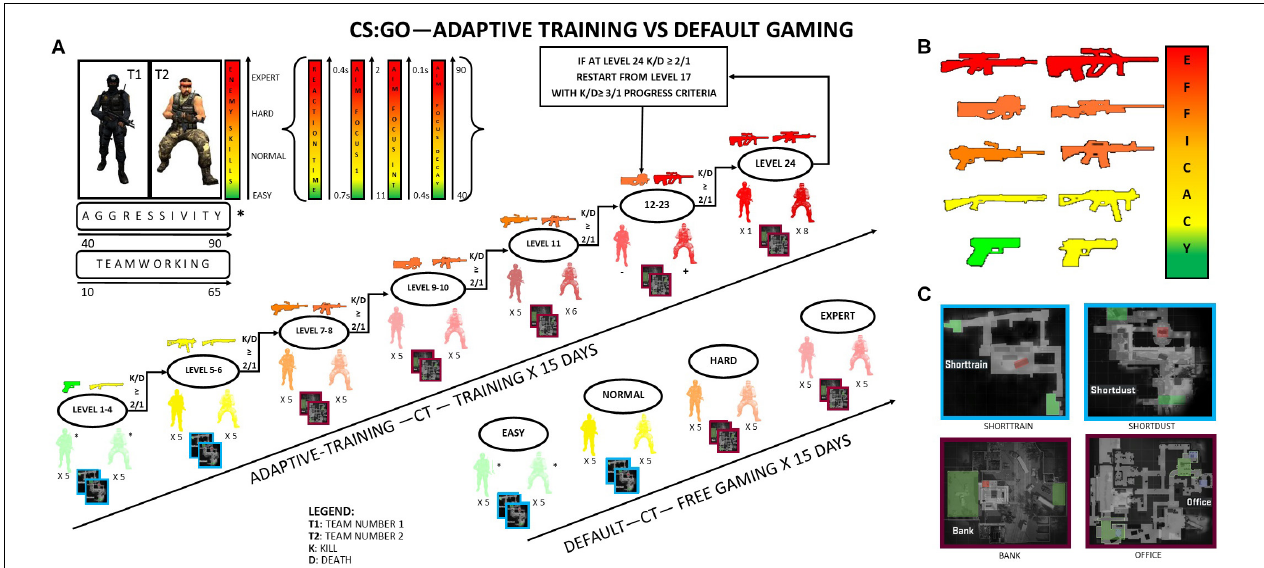
FIGURE 1 | Scheme of the experiment protocol. (A) At the beginning of the game, the player could join one of the two teams available in the game: Team 1 or Team 2. The A-CS:GO group played a customized game in which the progression in the game was established on the bases of the Death/Kill (K/D) ratio. If a player reached the K/D ≥ 2/1 for two consecutive rounds, he/she could proceed into the next level. Once reaching level 24, participants restarted from level 17 and could proceed to the next level only if he/she was capable of reaching a K/D ≥ 3/1. The D-CS:GO players could choose their difficulty level between four standardized games at the beginning of each round (*players joined a team and faced some enemies. The number of team bots and enemy bots was customized, as well as their skills ∗ ). (B) Weapons’ efficacy was set from the less (green–yellow) to the most (yellow–orange) dangerous on the bases of the extent of the capacity to cause damage, firing rate, and reload velocity. (C) Four different maps were available in the game. The smallest and easiest maps (Shorttrain and Shortdust) characterized the first levels of the A-CS:GO group and the Easy/Normal modality in the D-CS:GO group, whereas larger maps (Bank and Office) were proposed to challenge subjects in the A-CS:GO group and in Hard/Expert modality of the D-CS:GO group.